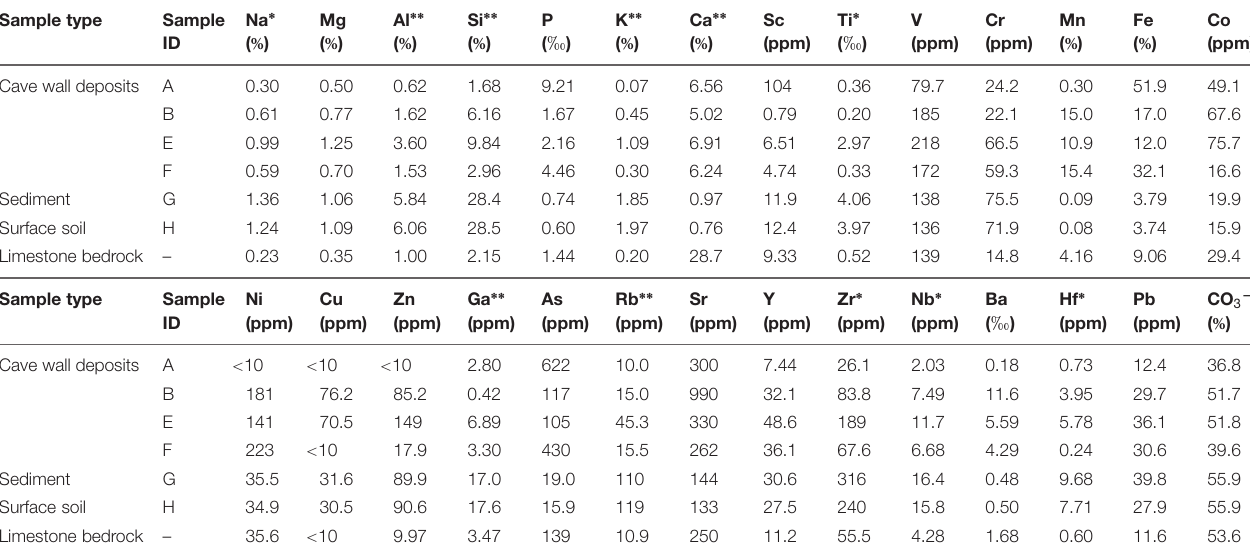
TABLE 1 | Major and trace element concentrations of samples collected inside in and outside Jinjia